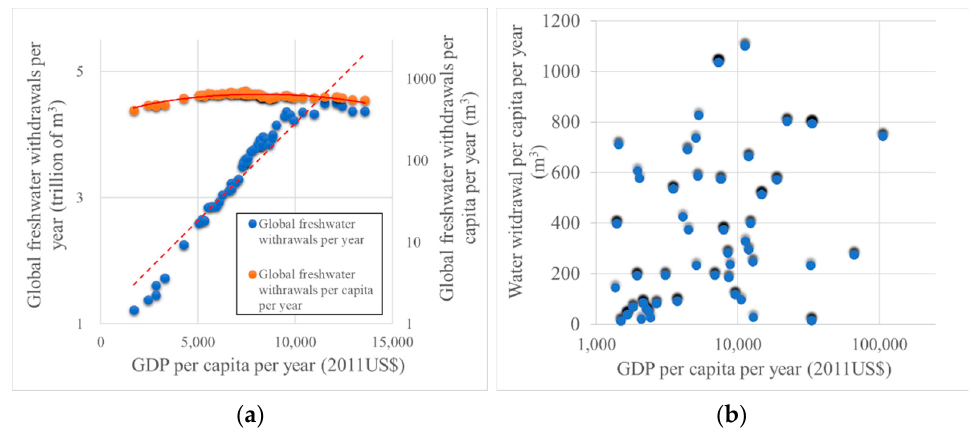
Figure 2. GDP per capita per year related to freshwater withdrawal; ( a ) global average through 1870–2011; ( b ) average per country in 2018 [60–63].